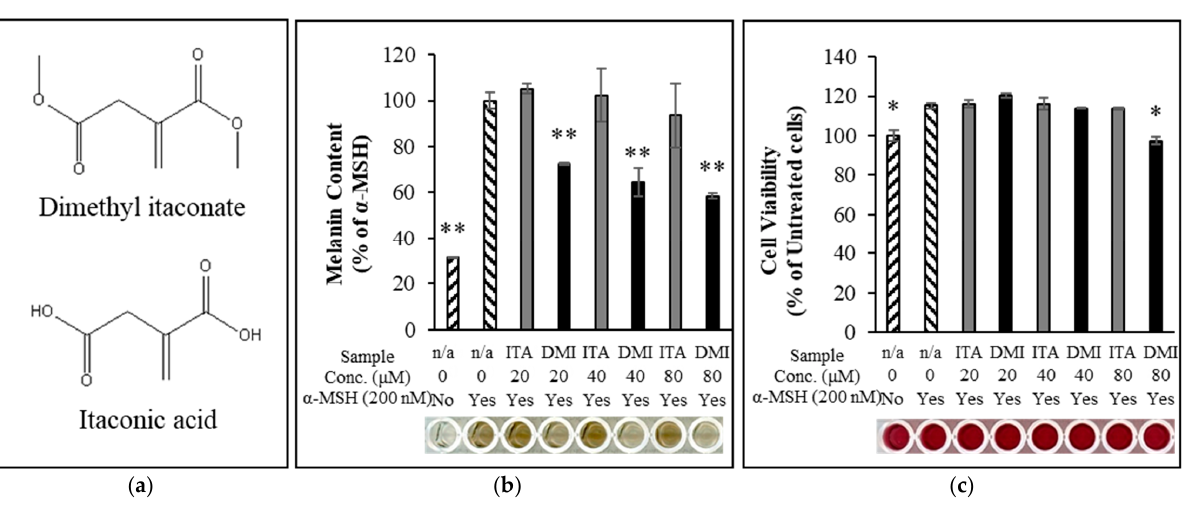
Figure 1. ( a ) Chemical structure of dimethyl itaconate (top) and itaconic acid (bottom). ( b ) Dime-